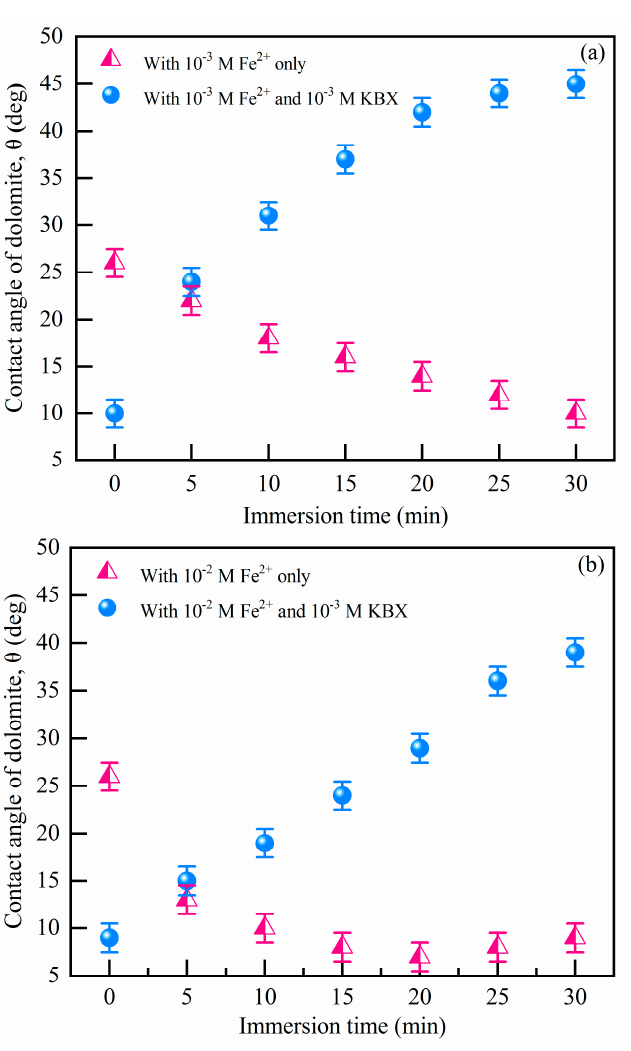
Figure 2. Contact angles of the dolomite surface in ( a ) 10 − 3 M Fe 2+ and ( b ) 10 − 2 M Fe 2+ solutions with different interaction times (pH = 8.5, c(SBX) = 10 − 3 M).